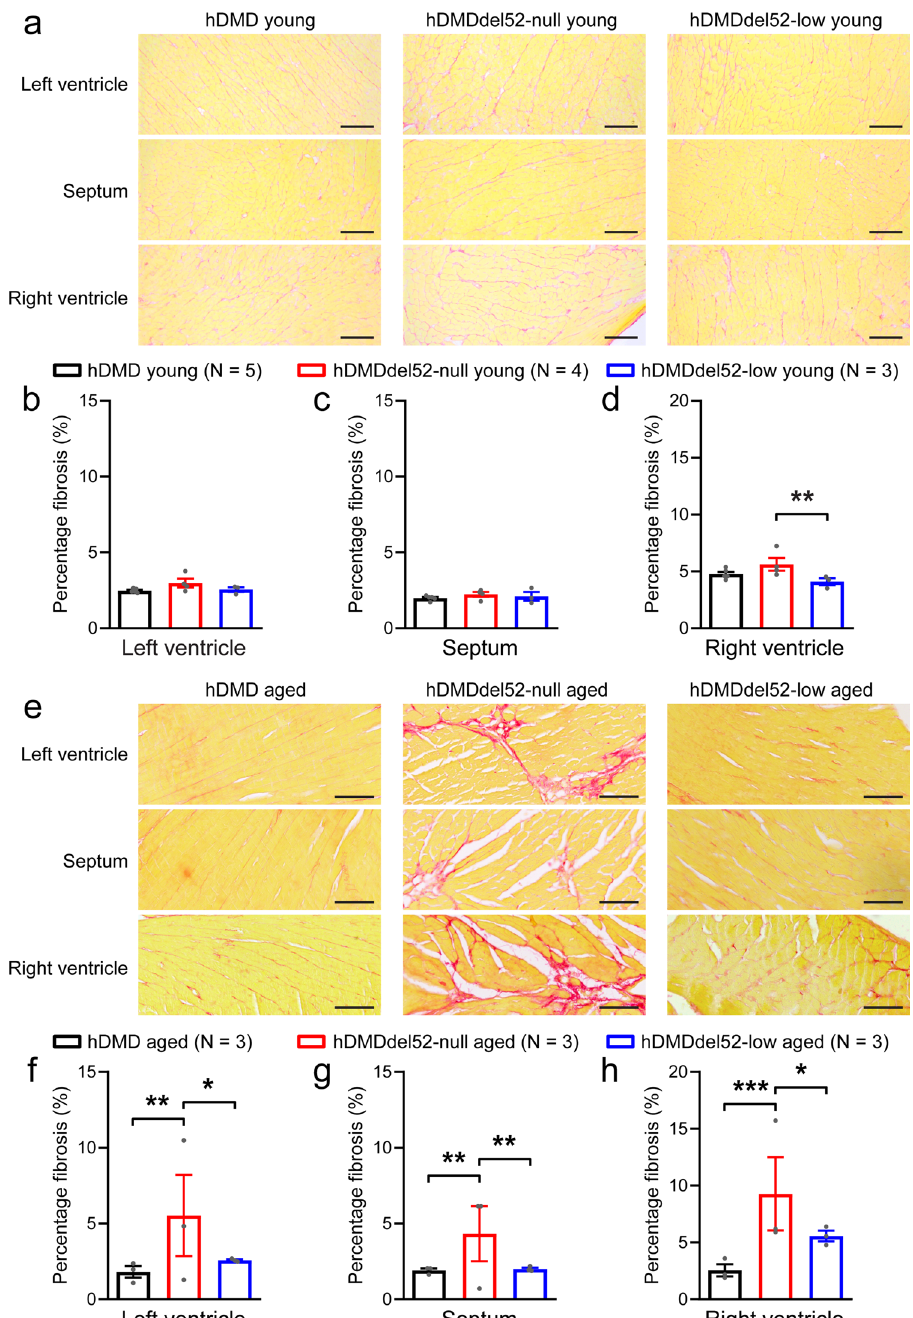
Figure 2. Enhanced myocardial fibrosis in aged mice in the absence of dystrophin, rescued in low dystrophin- expressing hearts. Picro Sirius Red staining was used to visualise and quantify myocardial fibrosis in hDMD, hDMDdel52-null, and hDMDdel52-low hearts. ( a ) Representative images used for analysis in young hearts. Average myocardial fibrotic area in left-ventricular ( b ), interventricular septal ( c ), and right-ventricular ( d ) myocardium measured in young hDMD (2.4 ± 0.2 months), hDMDdel52-null (3.0 ± 0.2 months), and hDMDdel52-low (3.2 ± 0.1 months) hearts. ( e ) Representative images used for analysis in aged hDMD (10.5 ± 0.9 months), hDMDdel52-null (11.2 ± 0.8 months), and hDMDdel52-low (10.7 ± 1.2 months) hearts. Average fibrotic area in left-ventricular ( f ), interventricular septal ( g ), and right-ventricular ( h ) myocardium. Scale bars: 100 µm, N represents the number of animals used for quantification. * P < 0.05, ** P < 0.01, *** P < 0.001 (nested one-way ANOVA with Tukey’s post-hoc